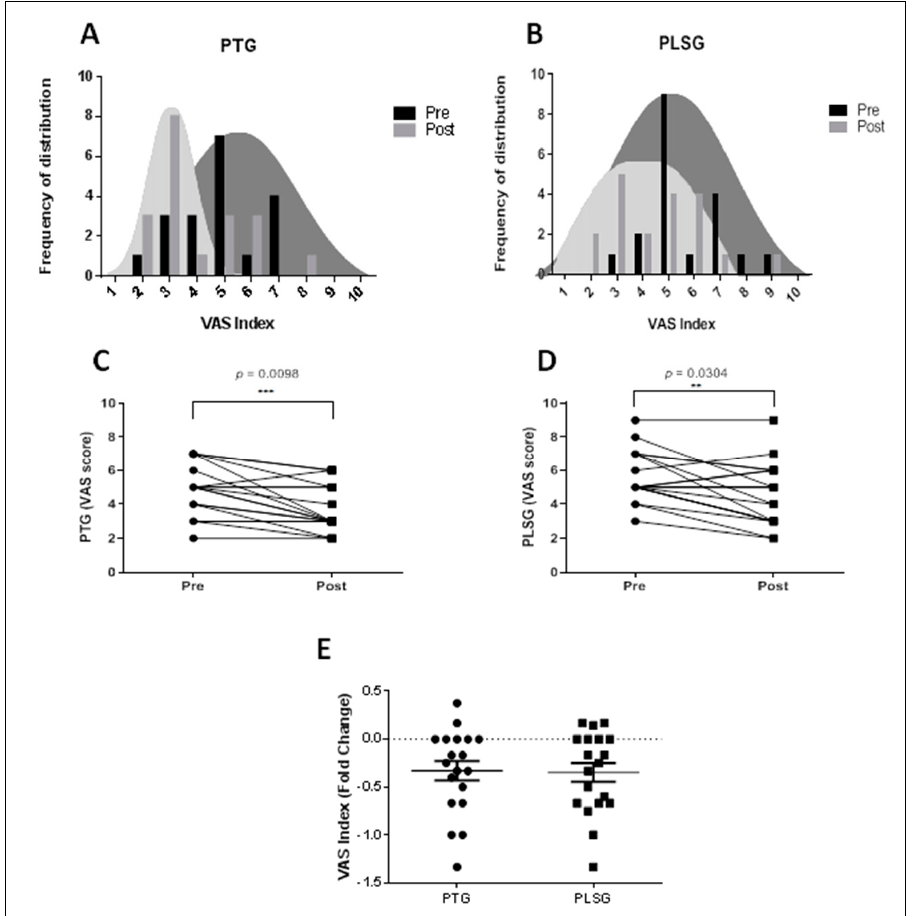
Figure 4. Changes in VAS score for PTG and PLSG pre − and post − treatment. ( A ) Frequency distribution of VAS index for PTG; ( B ) frequency distribution of VAS index for PLSG; ( C ) VAS score for PTG; ( D ) VAS score for PLSG; and ( E ) VAS index expressed in fold changes. Significant differences were considered statistically at ** p < 0.01 and *** p < 0.001. PLSG, personal low-frequency stimulation group; PTG, physical therapy group; VAS, visual analogue scale.